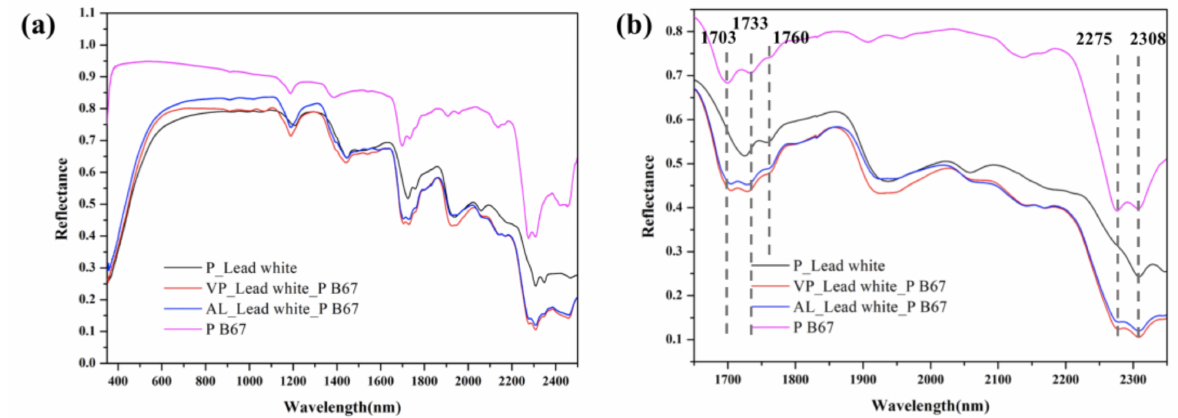
Figure 10. The full range reflectance spectrum ( a ) and the selected region reflectance spectrum ( b ) of pure P B67, lead white tempera mock-up (P), lead white tempera varnished with P B67 (VP) and mock-up after laser cleaning (AL). All spectra reported were collected in Section 8 of painting mock-ups (Figure 1).